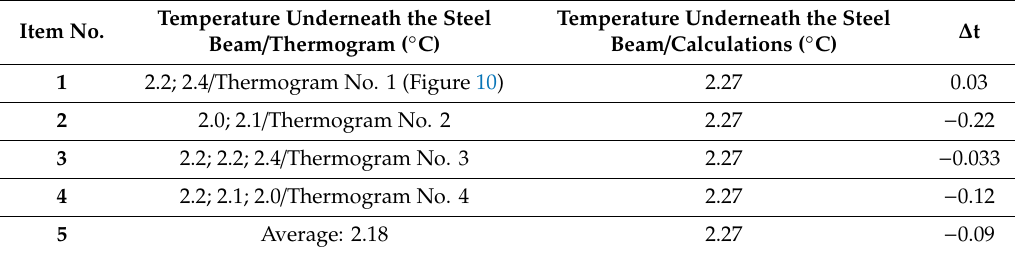
Note: ∆ t—di ff erence between the calculated value and measurement